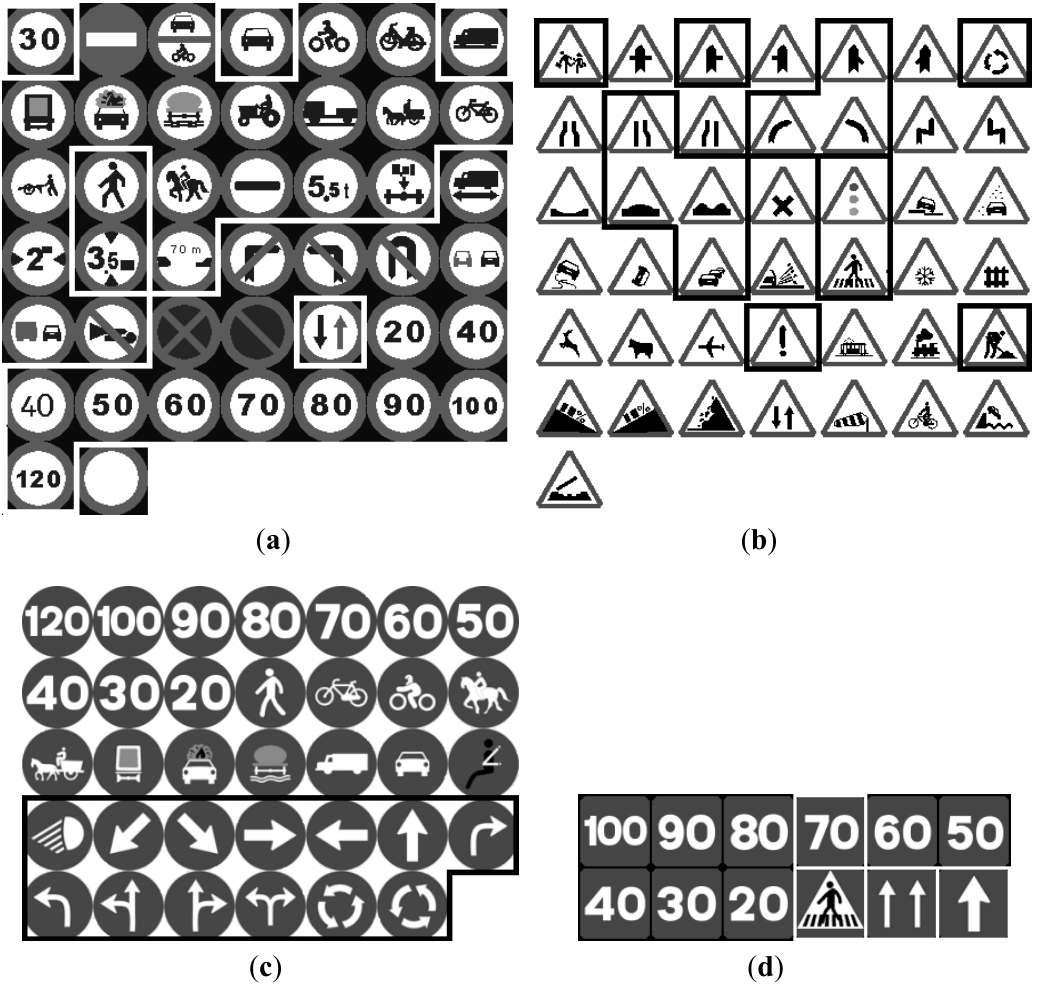
Figure 11. Examples of templates used for recognition by correlation with the candidates. The road signs which are framed correspond to the sets for NNs. ( a ) Prohibition road